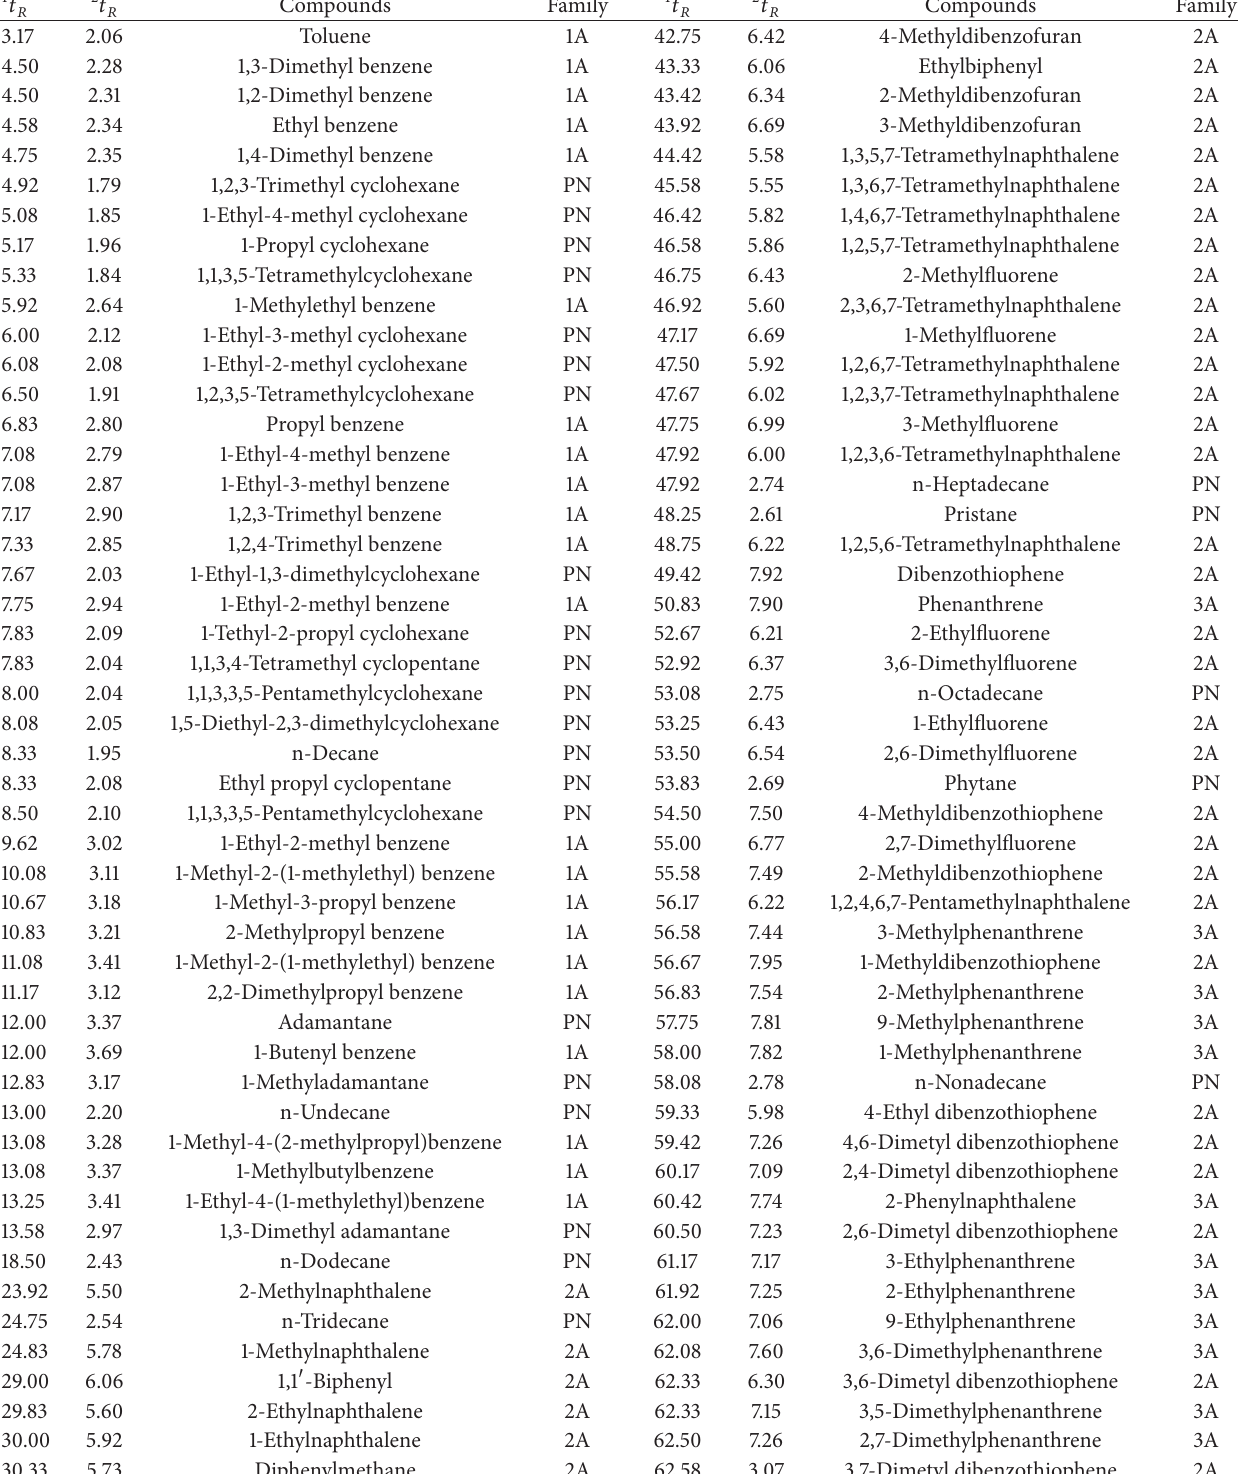
Table 2: Identification of some important paraffins, naphthens, and aromatic